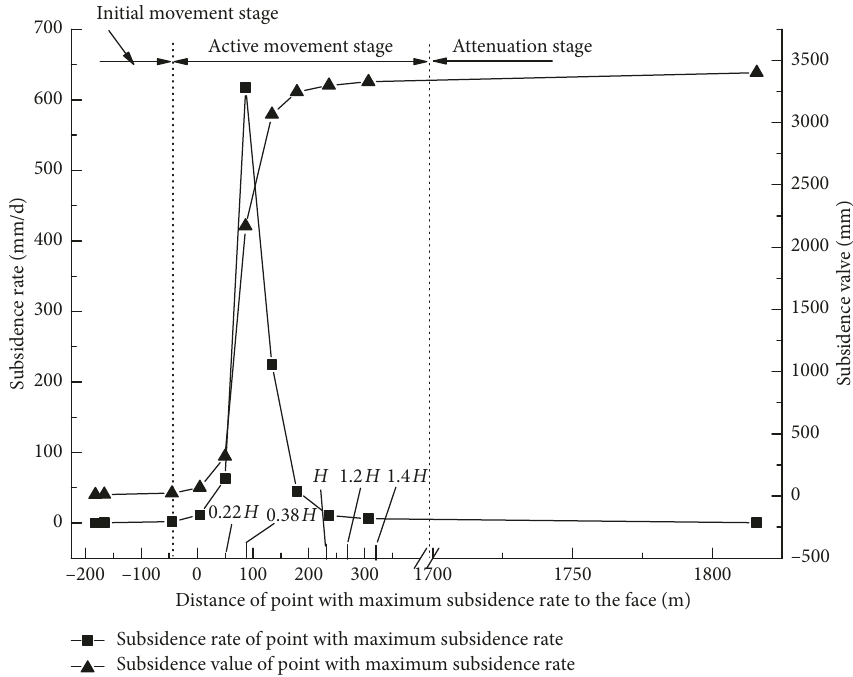
Figure 9: Dynamic subsidence rate curves of surface point with maximum subsidence